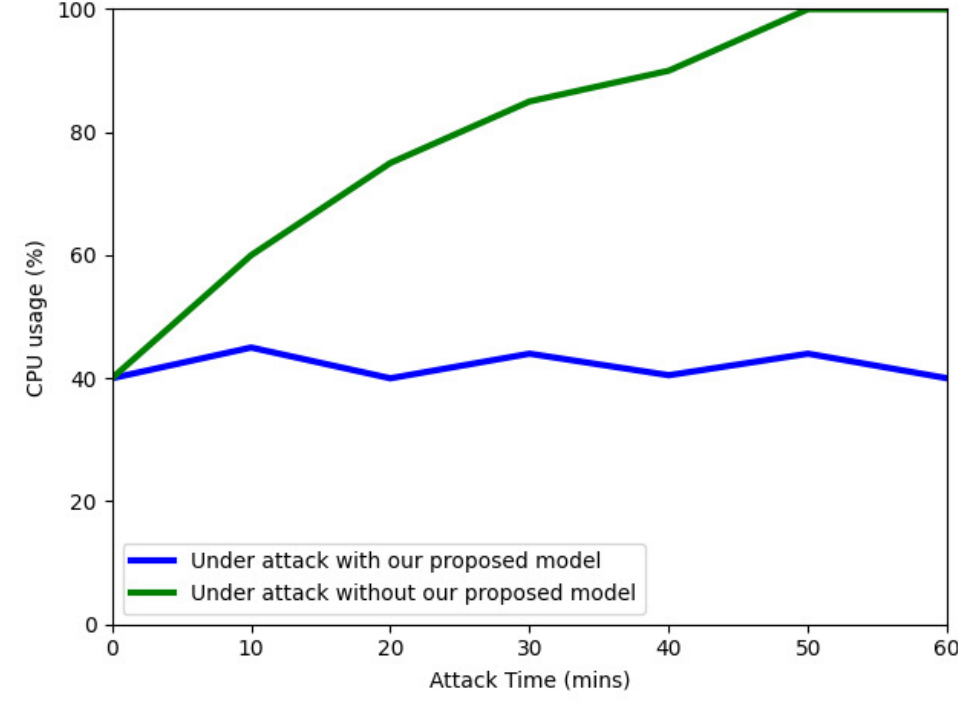
Figure 14. CPU usage of the victim server under control of the proposed